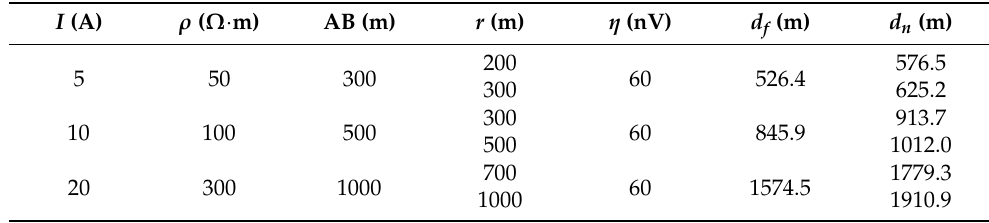
Table 2. Detectable depths of the far-area mode and near-area mode at different